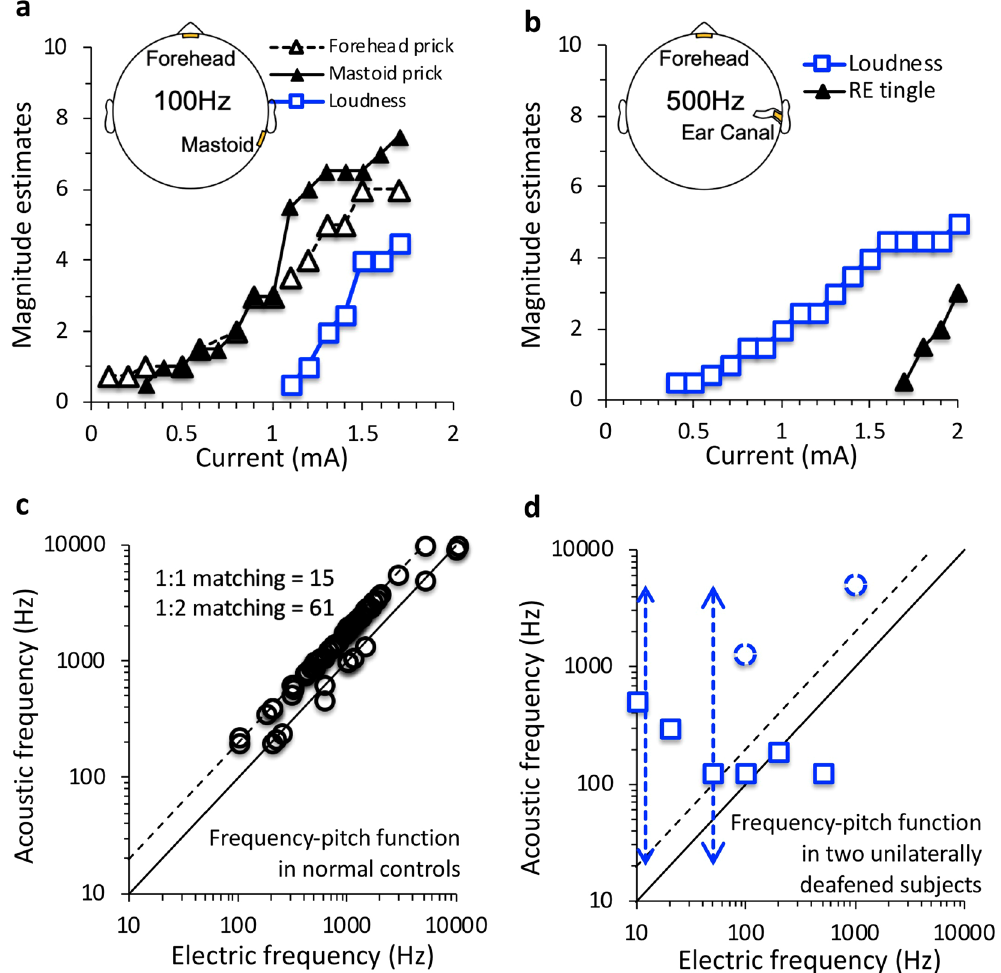
Figure 3. ( a ) Magnitude estimates as a function of electric current for right mastoid and forehead plate electrodes in an individual subject (blue = auditory sensation; black = somatic sensation). (b) Same as ( a ) except for right ear canal tiptrode and forehead plate electrode. ( c ) Frequency-pitch function from 14 normal- hearing subjects. The solid diagonal line represents 1:1 matches between acoustic frequency (y-axis) and electric frequency (x-axis). The dashed line represents 2:1 matches, with acoustic frequency doubling electric frequency. (d) Frequency-pitch function in 2 unilaterally deafened subjects (dashed lines and circles for one subject and solid squares for the other). The y-axis represents sound frequencies in the hearing ear matched to the frequency of electric stimulation delivered to the deaf ear (x-axis). Dashed lines = subject U1, Solid lines = subject U2 (See Subjects in